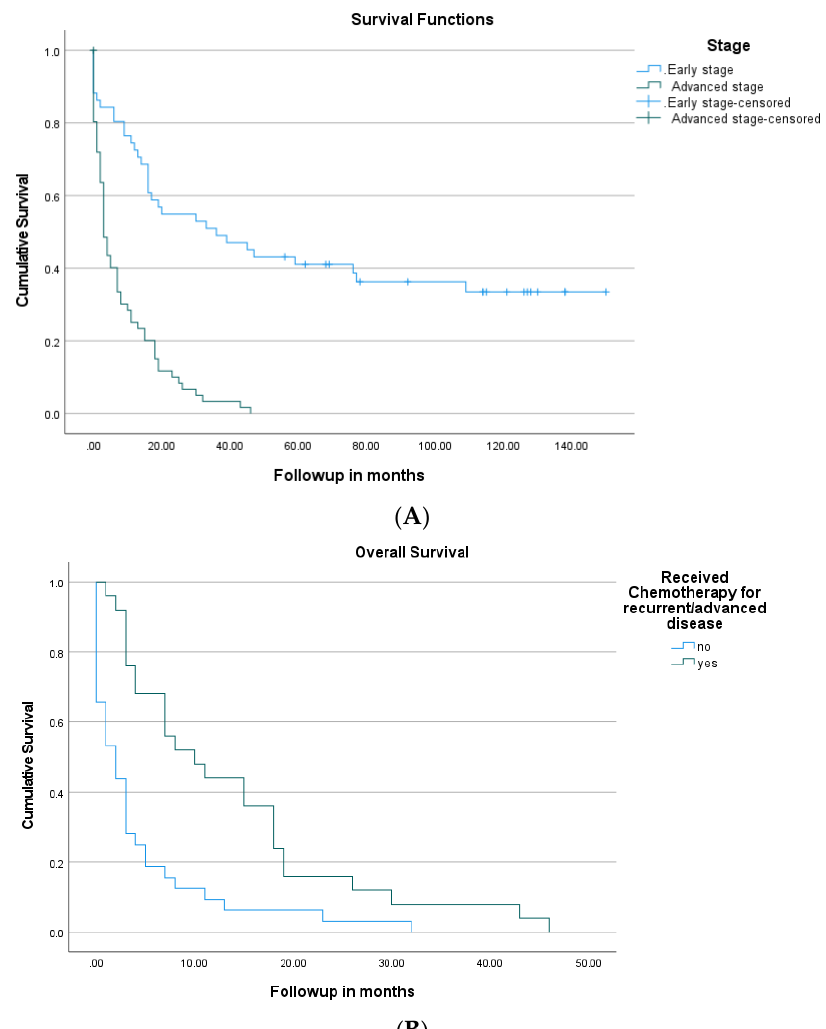
Figure 3. ( A ): Comparison of Kaplan – Meier survival curves of patients with early-stage disease to those with advanced disease. ( B ): Comparison of Kaplan – Meier survival curves of patients with advanced-stage small intestine adenocarcinoma who were treated with chemotherapy vs. no chemotherapy.